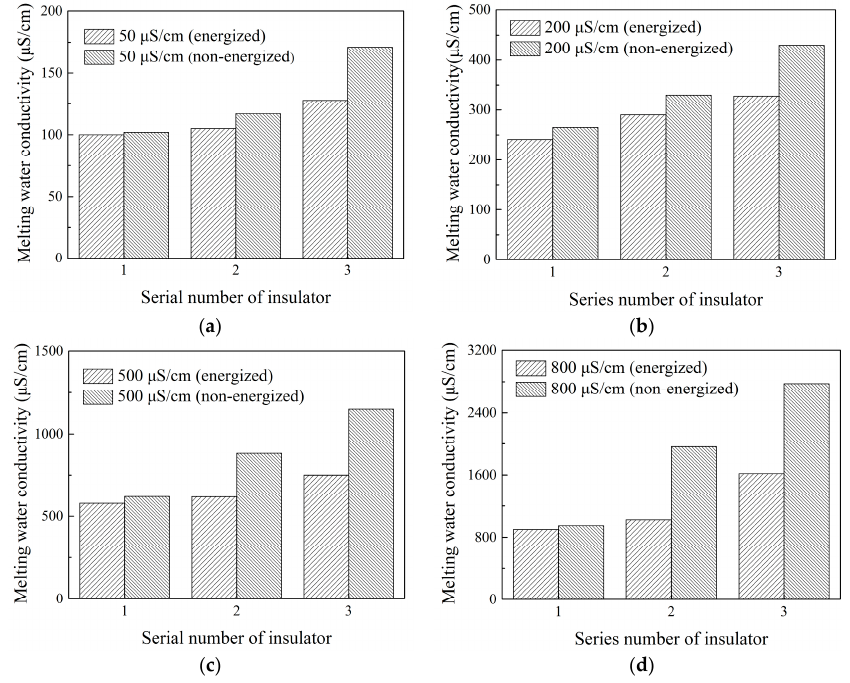
Figure 9. Melting water conductivity under energized and non-energized conditions: ( a ) 50 μ S/cm; ( b ) 200 μ S/cm; ( c ) 500 μ S/cm; and ( d ) 800 μ S/cm.